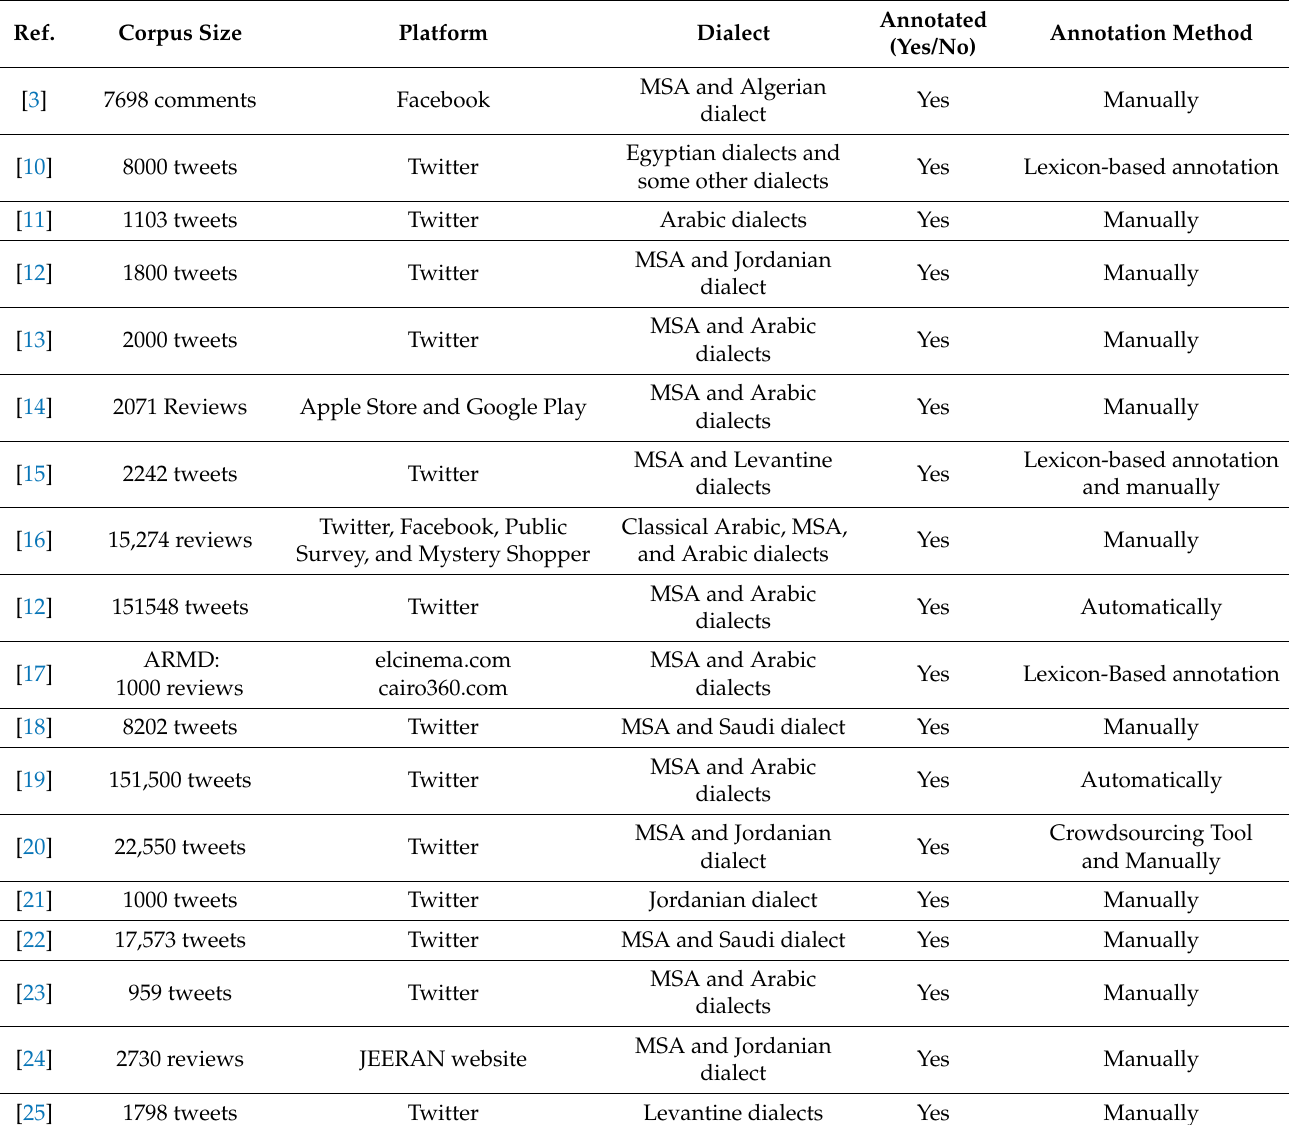
Table 1. Datasets constructed for Arabic